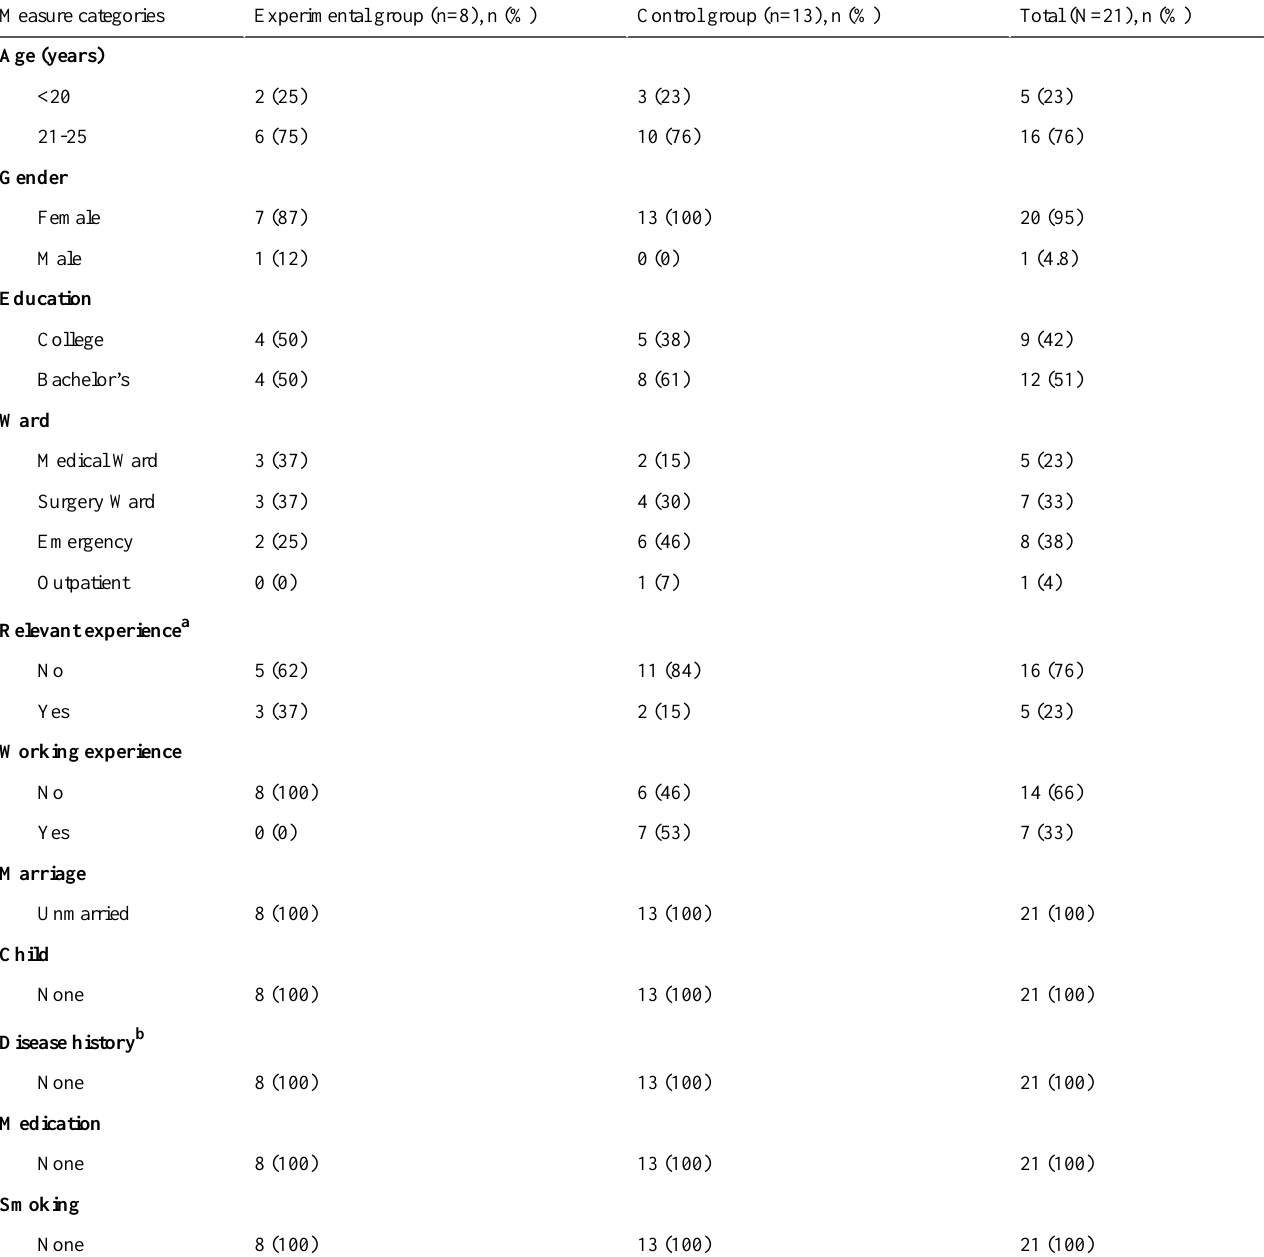
Table 2. Basic information of the